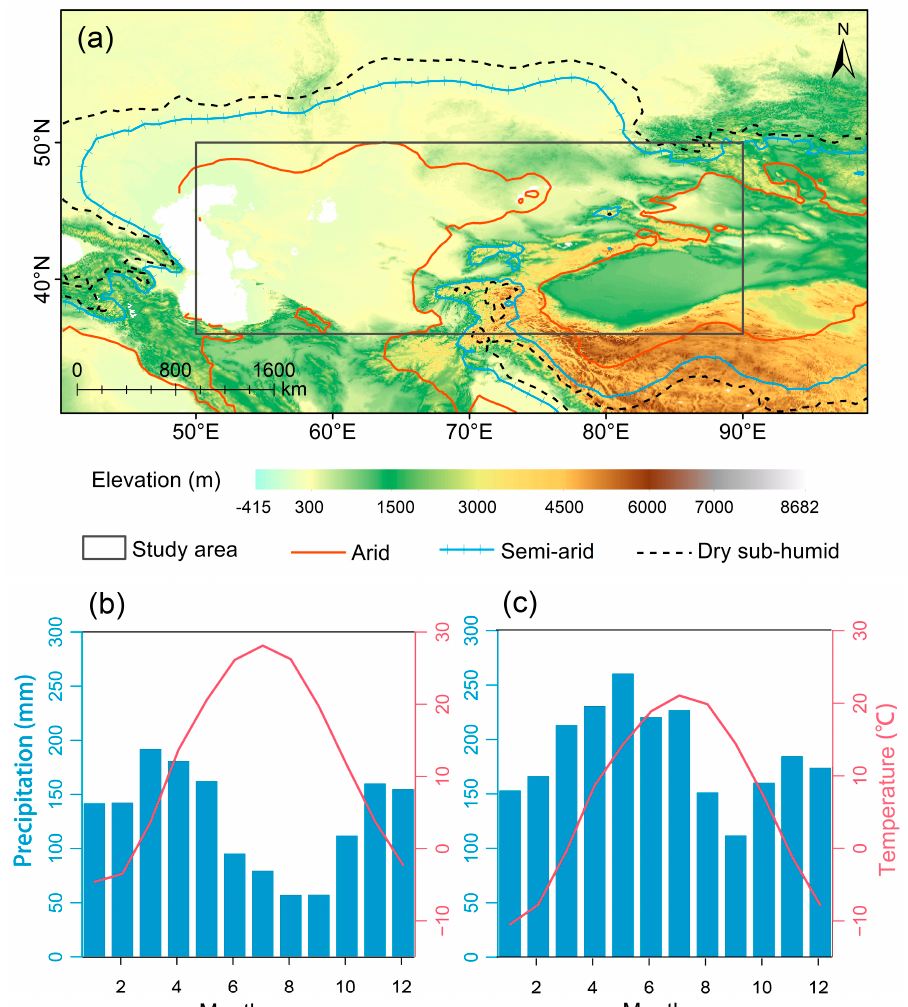
Figure 1. ( a ): Location and topographic characteristics of the study area. The rectangle with a black border is the study area of this study. The different shapes and colors of lines are the dividing lines between arid, semi-arid, and dry sub-humid areas. The average monthly temperature and precipitation in the western arid central Asia (ACA) ( b ) and the eastern ACA ( c ). The blue bars represent precipitation, and the red curves represent temperature.